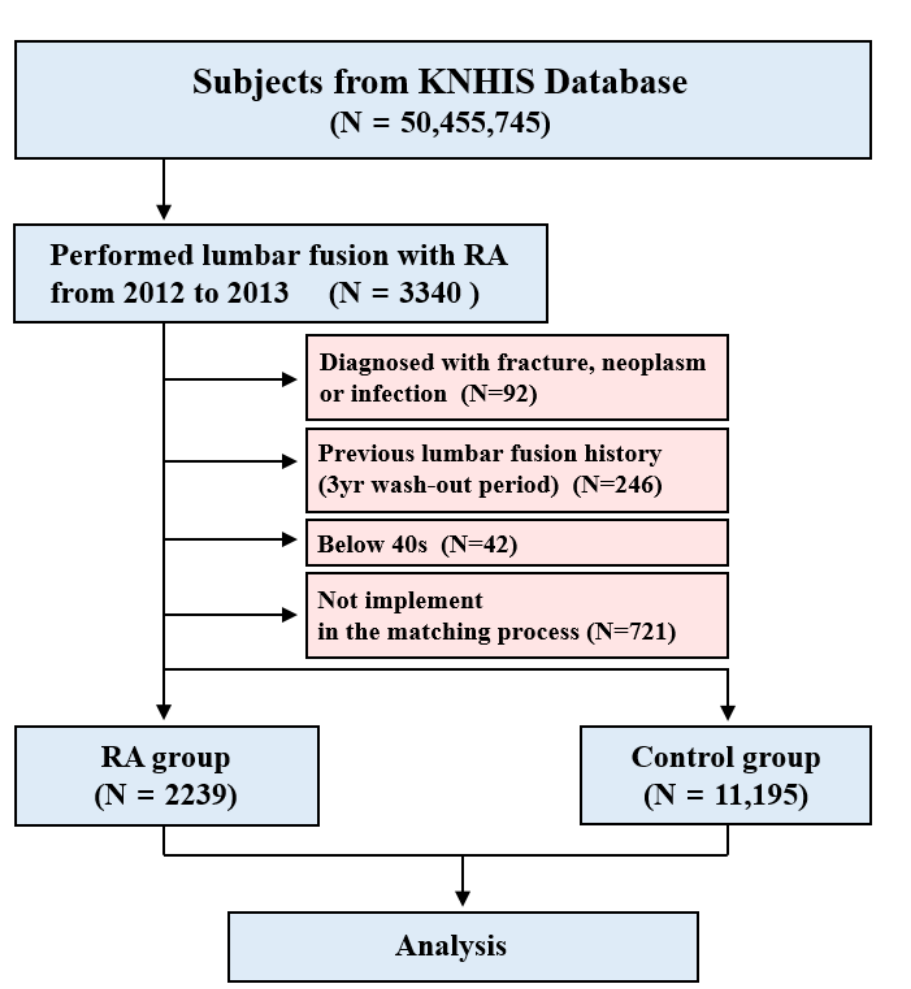
Figure 1. Flowchart of subjects from the Korean Health Insurance Review and Assessment Service (HIRA).